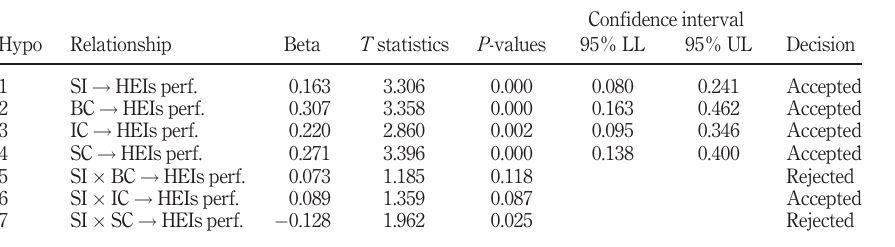
Table V. Results of